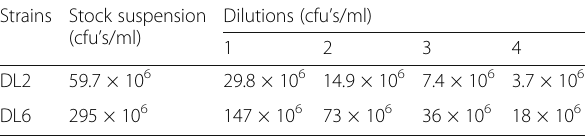
Table 2 Preparation of different cell concentration (cfu ’ s/ml) of the two selected isolates for per os bioassay technique Strains Stock suspension (cfu ’